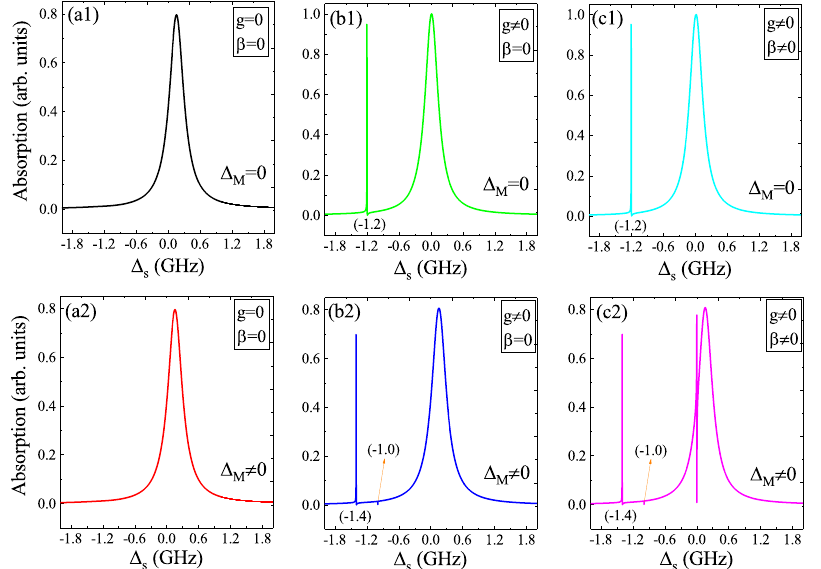
Figure 2. ( a1 , a2 ) The absorption spectra versus the probe–exciton detuning ∆ s for the parameters of g = 0, β = 0, ∆ c = ω m under the condition of ∆ M = 0 and ∆ M (cid:54) = 0, respectively. ( b1 , b2 ) The absorption spectra versus ∆ s for the parameters of g = 0.1 GHz, β = 0, ∆ c = ω m under the condition of ∆ M = 0 and ∆ M (cid:54) = 0, respectively. ( c1 , c2 ) The absorption spectra versus ∆ s for the parameters of g = 0.1 GHz, β = 0.06, ∆ c = ω m under the condition of ∆ M = 0 and ∆ M (cid:54) = 0,